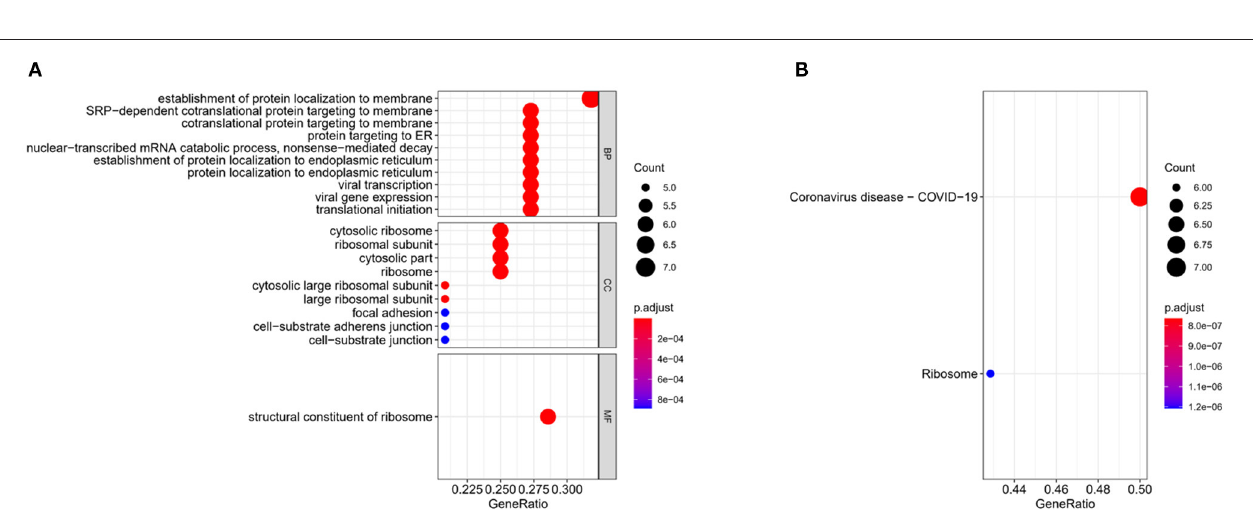
FIGURE 2 | PCA and cluster heatmap analysis based on feature genes in the KNN classifier. (A) PCA shows the classification performance of the KNN classifier in COVID-19 negative (red) and positive (green) populations. (B) Cluster heatmap showing the expression of feature genes in the KNN classifier. Red indicates high expression and green indicates low expression.